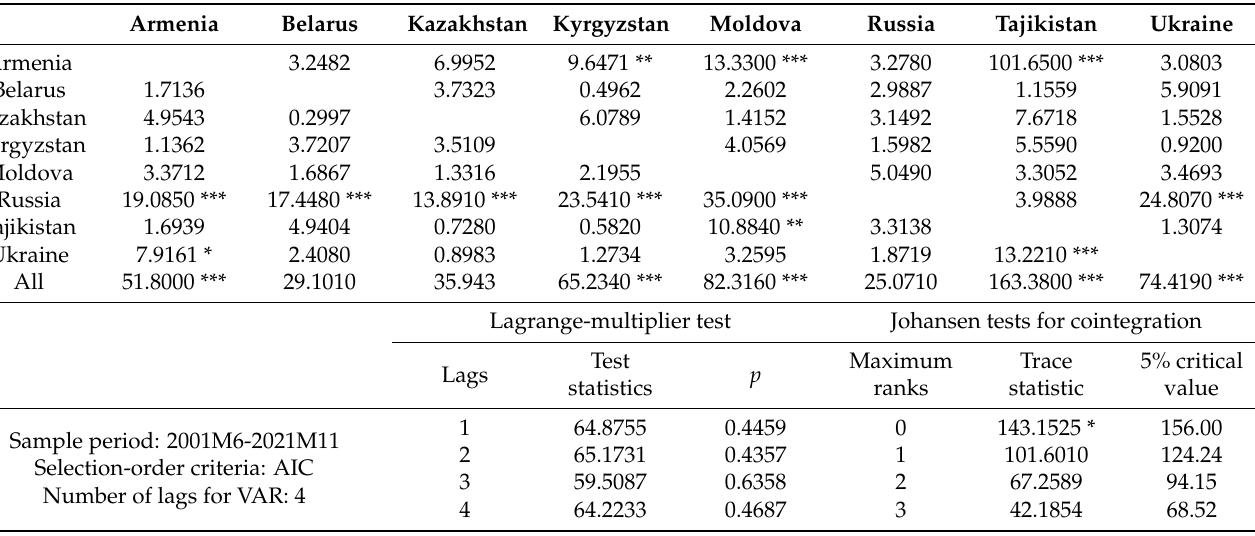
Table 12. Granger Causality Tests, Monthly Exchange